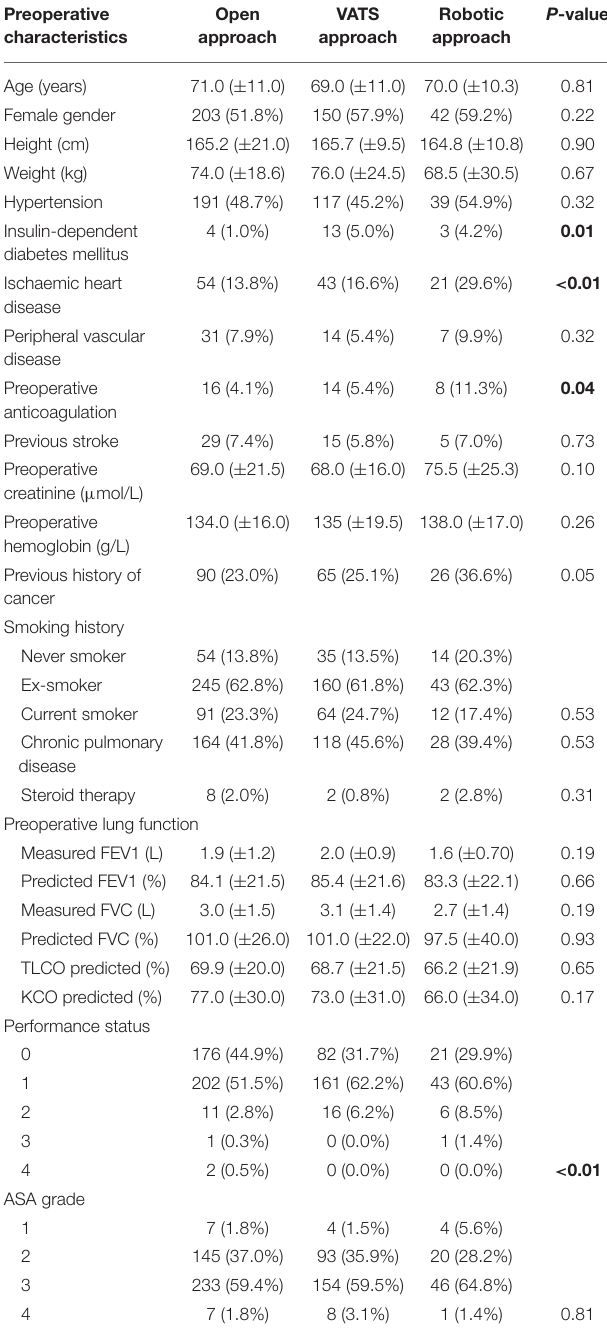
TABLE 1 | Baseline patient characteristics for alternative operative